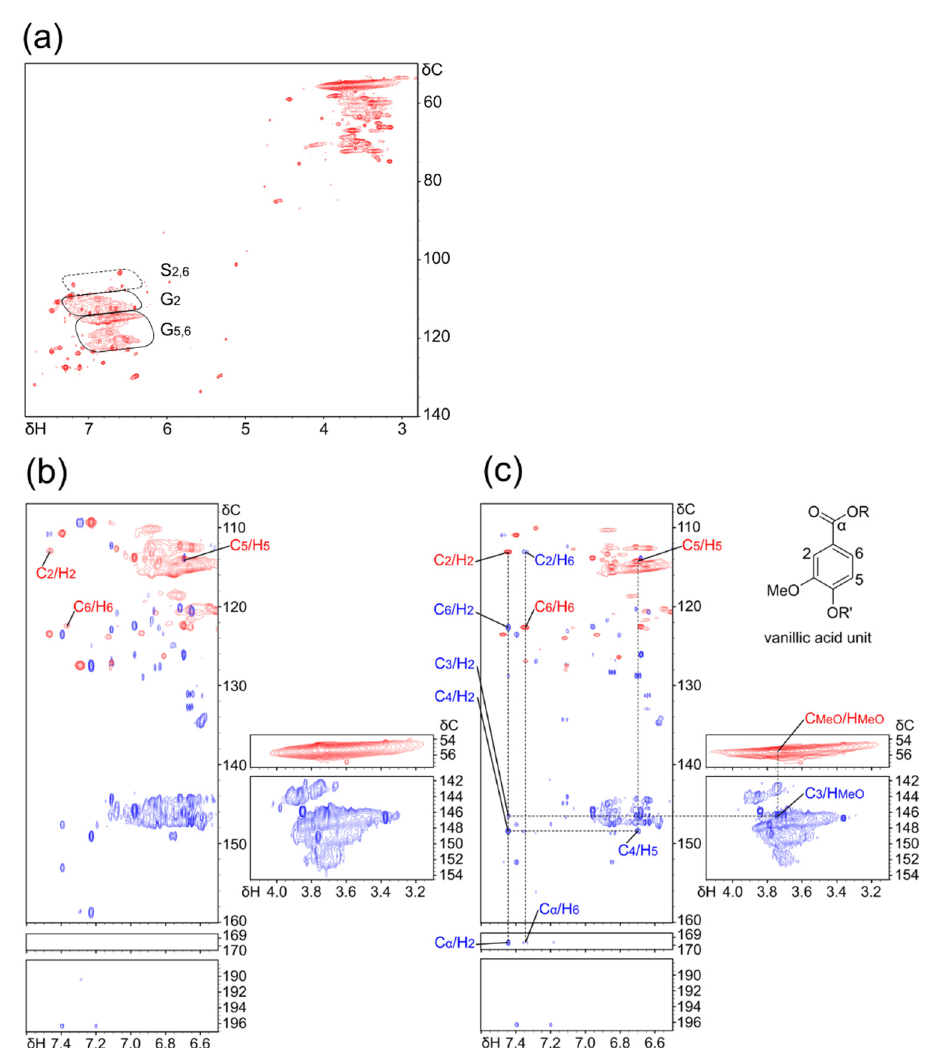
Figure 4. 2D NMR analysis. ( a ) Superimposition of partial 2D 13 C- 1 H HSQC of lignin sample before irradiation in DMSO-d6. Vertical and horizontal axes are chemical shifts in parts per million (ppm) for 13 C ( δ C) and 1 H ( δ H), respectively. Typical aromatic spectral regions for 13 C and 1 H of syringyl (S) and guaiacyl (G) moieties are indicated. ( b , c ) Superimposition of partial 2D 13 C- 1 H HSQC (red) and 2D 13 C- 1 H HMBC (blue) spectra of lignin before ( b ) and after ( c ) irradiation in DMSO-d6. The signals corresponding to vanillic acid are labeled (refer to upper right structural formula). Vertical and horizontal axes are chemical shifts in parts per million (ppm) for 13 C ( δ C) and 1 H ( δ H), respec- tively.